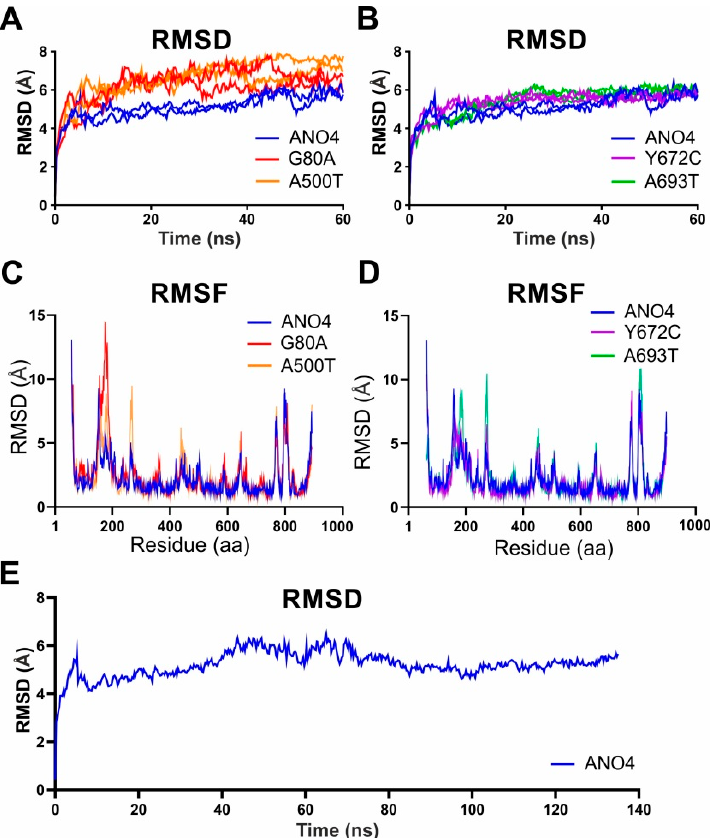
Figure 4. Molecular dynamics simulation of native and mutant ANO4 structures. ( A , B ) The RMSD values of native and mutant structures from two independent simulations are shown as a function of time after 60 ns of MDS. G80A and A500T structures exhibited significantly increased structural deviation in comparison to ANO4 WT, Y672C and A693T mutant structures. ( C , D ) RMSF of the central alpha carbon per residue over entire simulation of native and mutant structures. ( E ) The stability of native ANO4 structure was evaluated during 135 ns of MDS, showing that ANO4 WT structure reached equilibrium after 10 ns and remained stable afterwards. Table 2. Average structural properties calculated for the full length ANO4 wild-type, G80A, A500T, Y672C, and A693T structures and corresponding standard deviations (in parentheses). * Significant at p < 0.05 are depicted in bold and with asterisk.